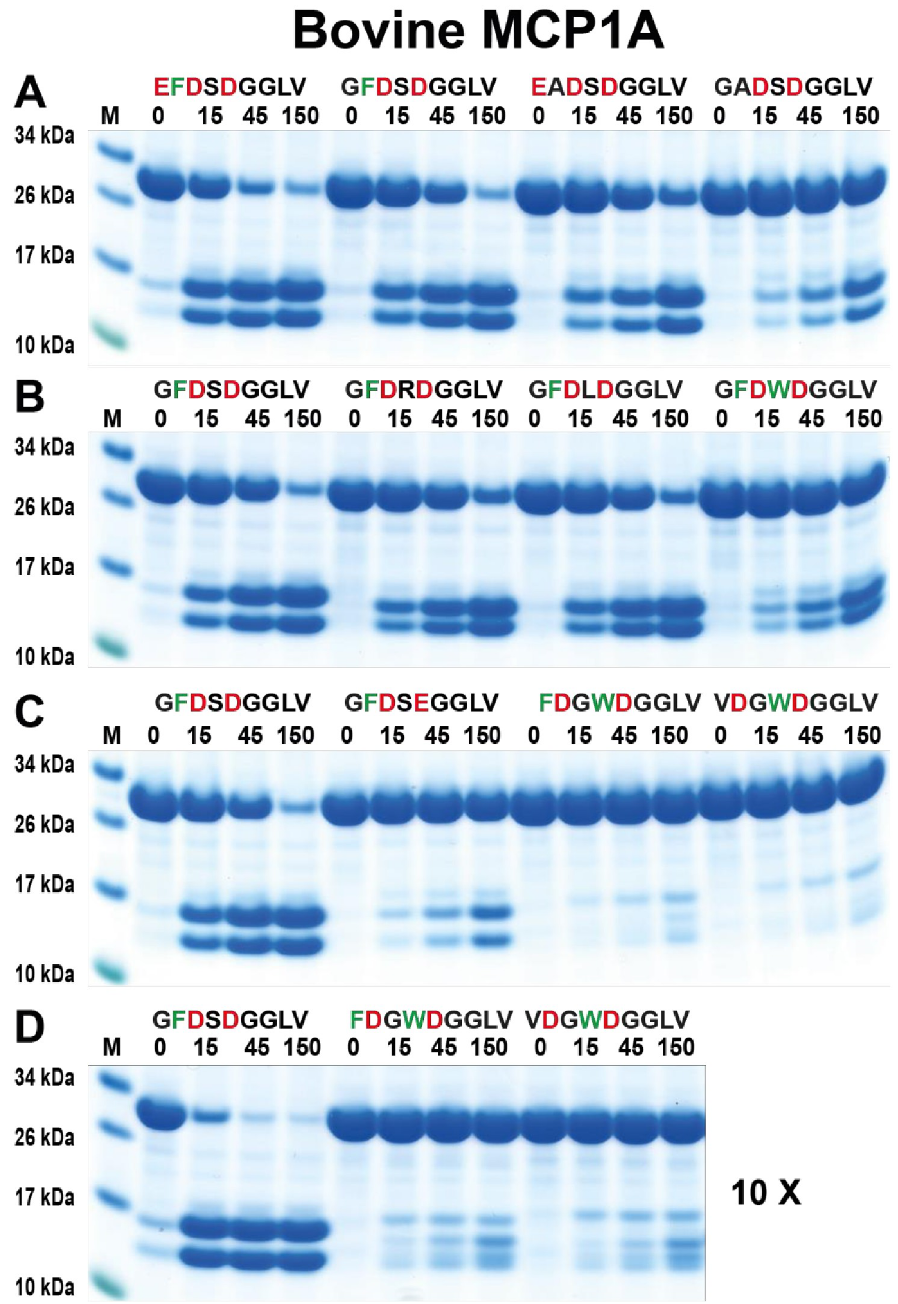
Fig 8. Verification of the cleavage specificity of bovine MCP1A by the use of recombinant protein substrates. Panels from A to D show the cleavage of a number of substrates by bovine MCP1A. The sequences of the different substrates are indicated above the pictures of the gels. The time of cleavage in minutes is also indicated above the corresponding lanes of the different gels. The uncleaved substrates have a molecular weight of ~25 kDa and the cleaved substrates appear as two closely located bands with a size of 12–13 kDa. Residues of particular interest and that may differ between different substrates are marked in red or green for an easy identification. In panel D, we used 10-fold more enzyme compared to the other cleavage